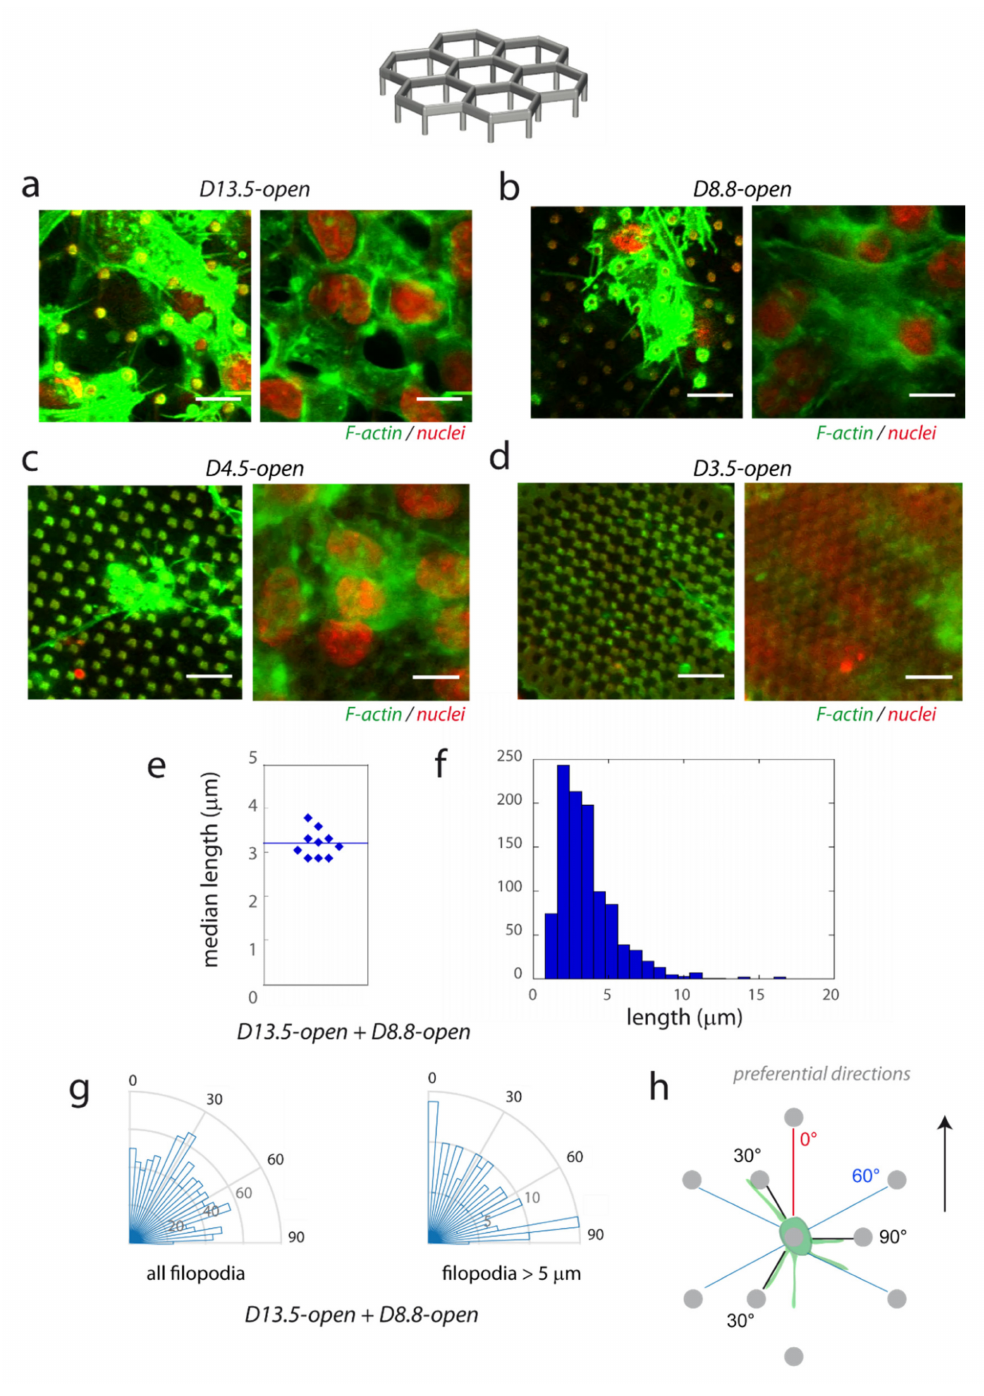
Figure A5. Filopodia characterization on regular microstructures. HUVECs were cultivated on regular open microstructures with different horizontal dimensions D : ( a ) D13.5-open , ( b ) D8.8-open , ( c ) D4.5-open , ( d ) D3.5-open . Bottom and top planes are represented. Red: nuclei and microstructure autofluorescence, green: F-actin. Cells were fixed at time of structure colonization (2 days after cell seeding). Denoised images, bar 10 µ m. ( e ) Median filopodia lengths in D13.5-open + D8.8-open microstructures, one point corresponds to one structure (bar: average value). ( f ) Histogram of filopodia lengths in D13.5-open + D8.8-open microstructures. ( g ) Histograms of filopodia orientations in D13.5-open + D8.8-open structures. The angle with the reference axis of elongated structures was computed. Left: all filopodia, right: filopodia with lengths > 5 µ m. ( h ) Remarkable